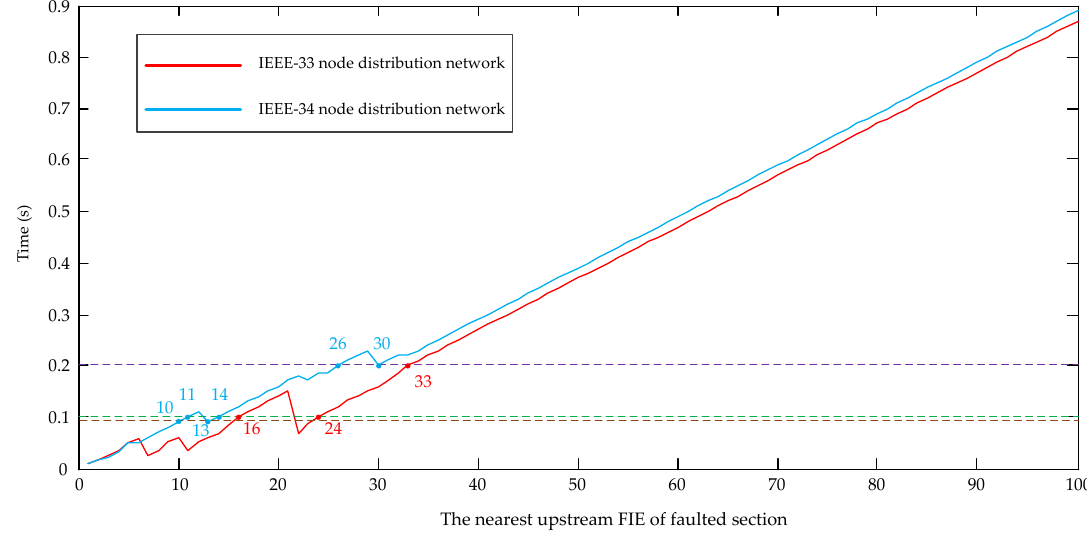
Figure 13. Simulation results of expanded distribution network.